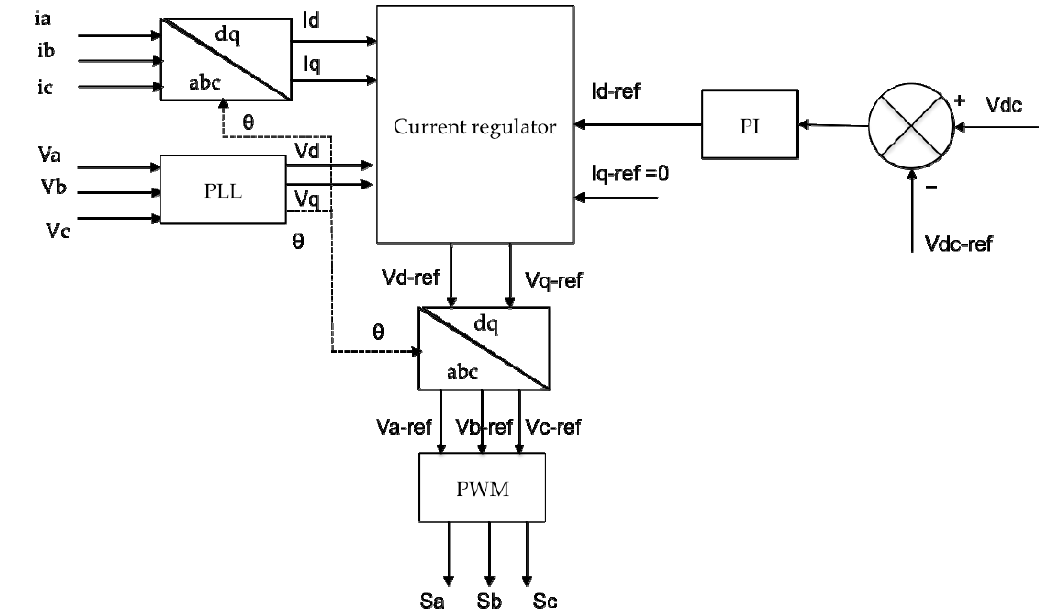
Figure 6. Control diagram of the grid ‐ side inverter, PLL: phase ‐ locked loop.